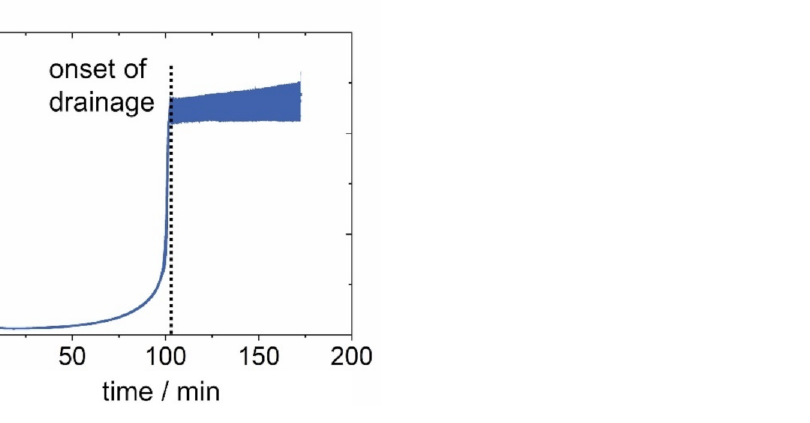
Figure 12. Area of the differential pressure of the salt-laden filter with standard deviation during exposure to water mist.